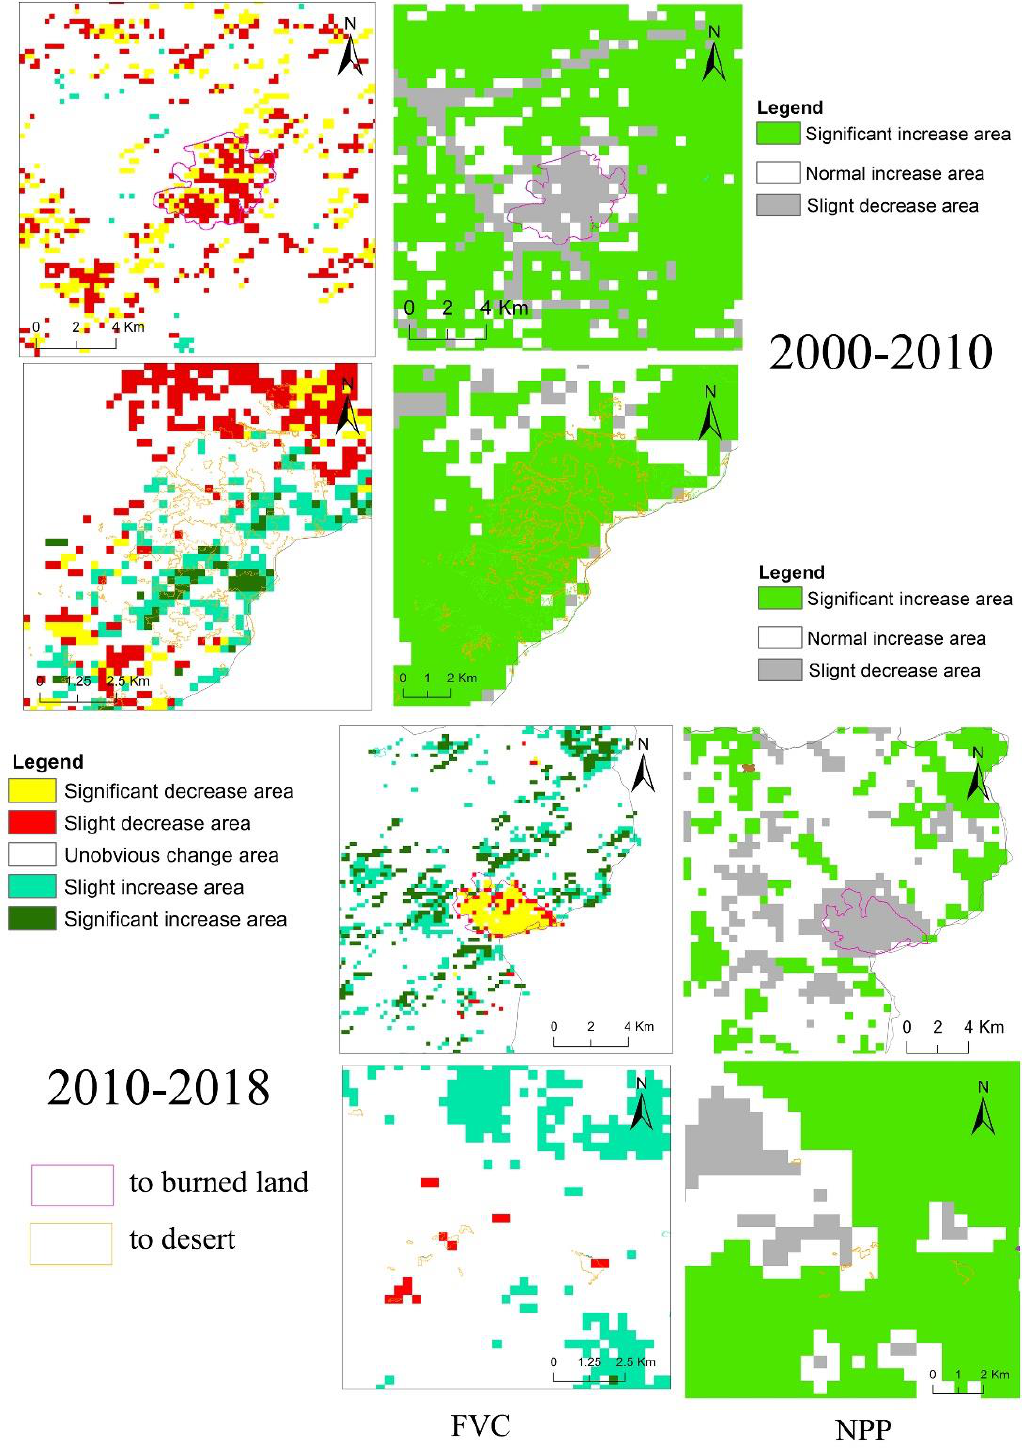
Figure 13. The FVC and NPP changes of the increase areas of burned land and desert.